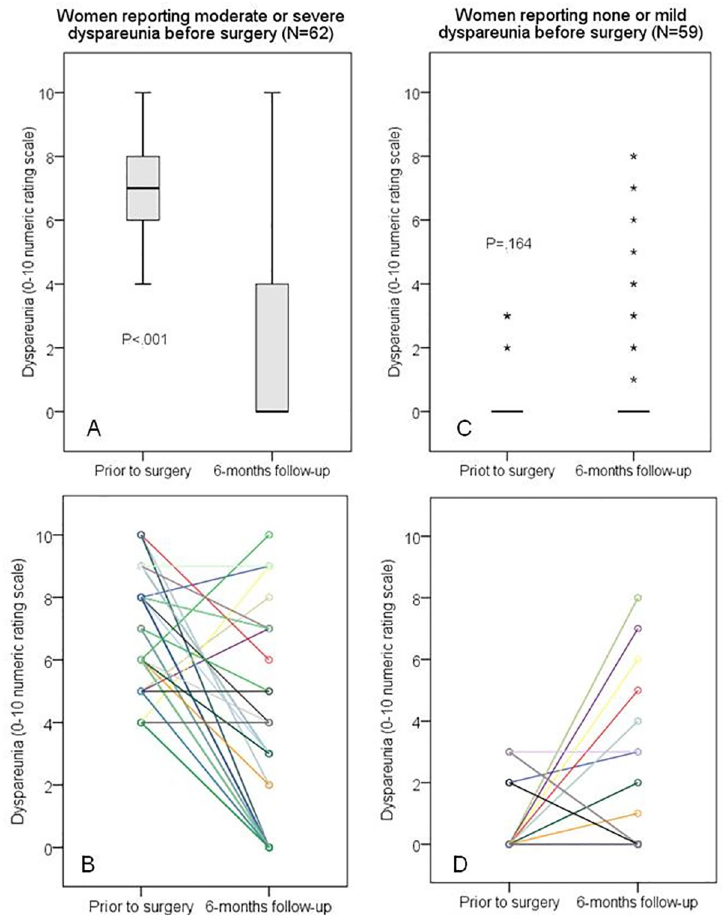
Fig 2. The severity of deep dyspareunia (primary outcome). It was assessed on a self-reported 11-point numeric rating scale (NRS) in two moments: prior to surgery (during the preoperative evaluation period) and at six-month follow-up (N = 121). (A) and (C): Boxplots show the 25 th , 50 th , and 75 th percentiles; nonparametric independent- samples Mann-Whitney U test was used for comparison (P < .001); asterisks were used to identify extreme outliers (values higher than 3 x interquartile range). (B) and (D): Point to point lines highlighting the different individual changes; the lines were colored just to emphasize being different women (coincidentally, some cases generated overlapping